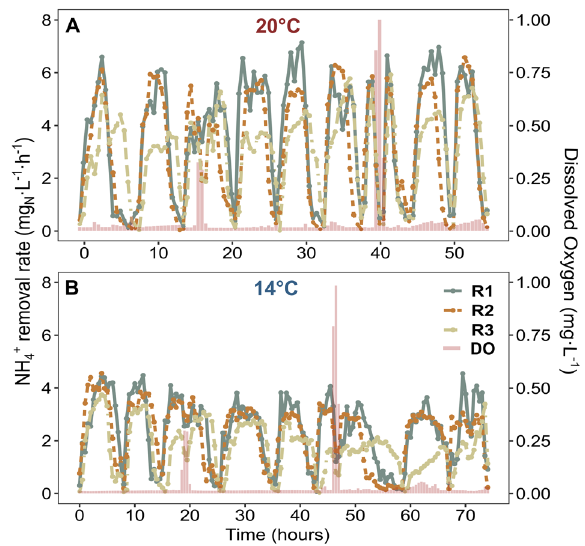
Fig. 2 Process level performance. A NH 4 + removal rates per hour over nine SBR cycles (20 °C). x -Axis denotes the time in hours, the y -axis (left) displays the NH 4 + removal rate in mg Nitrogen/Liter/hour. Colors of the linecharts denote the different reactors (green: Reactor1; brown: Reactor2; beige: Reactor3). Concentrations of dissolved oxgen (red bars) in mg DO/ Liter are shown on the second y -axis (right). B NH 4 + removal rates per hour over nine SBR cycles (14